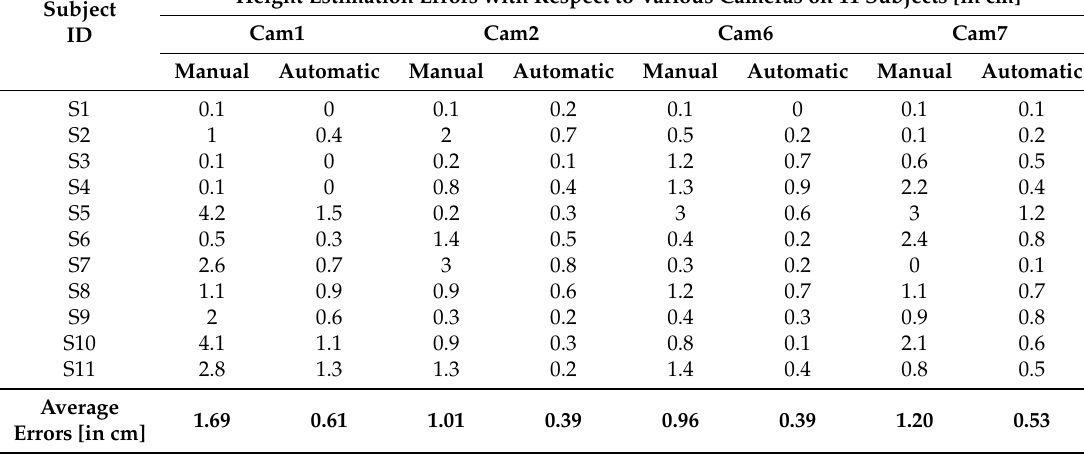
Table 4. Quantitative comparison: Average height estimation errors with respect to various cameras on 11